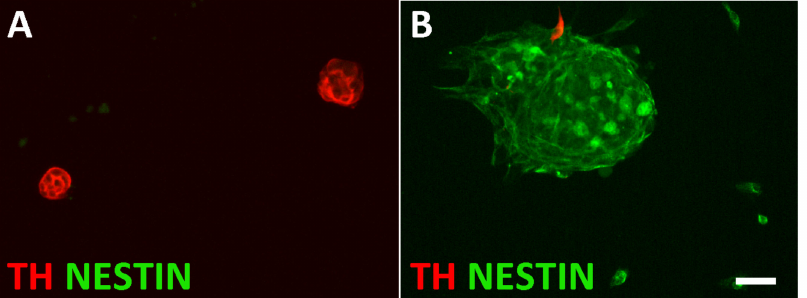
Figure 4. Characterization of sphere cultures from L1CAM-positive and L1CAM-negative cells. L1CAM-positive spheres are composed of TH-expressing cells ( A ), whereas L1CAM-negative spheres are largely composed of NESTIN-positive cells ( B ). Magnification bar, 60 µ